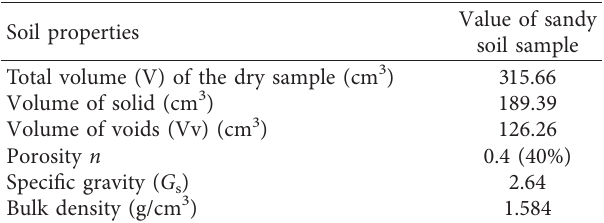
Figure 2: Grain size distribution and sieve analysis of the clean pure sand. Table 2: Properties of clean sandy